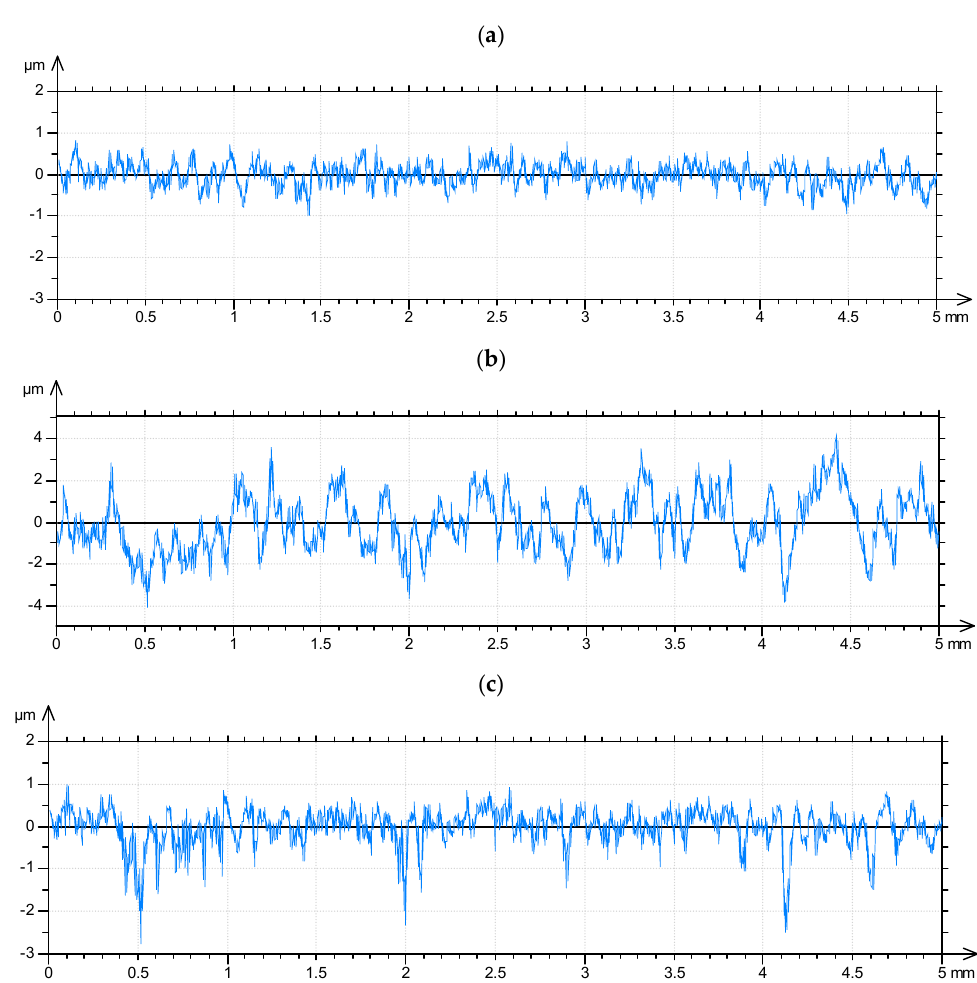
Figure 13. Example of generation of two-process random profile: ( a ) plateau profile: Rq = 0.3 µm, CL = 25 µm, ( b ) valley profile Rq = 1.4 µm, CL = 90 µm, ( c ) two-process profile, Rmq = 85%.